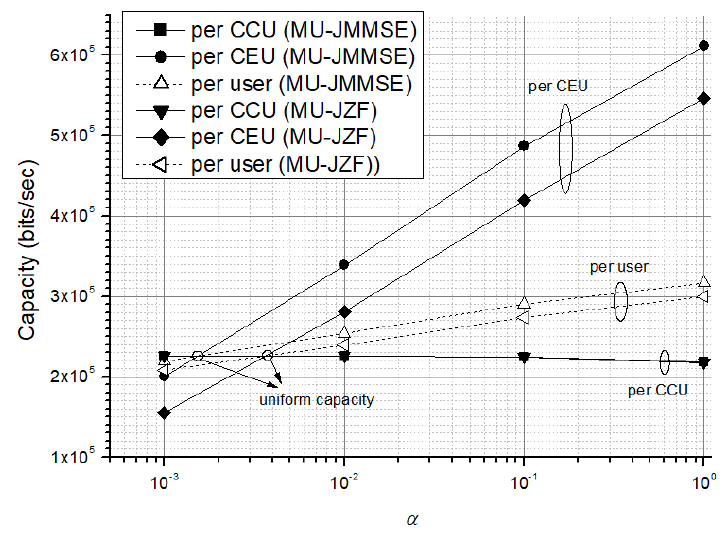
Figure 8. Capacity comparison for joint preprocessing schemes in MU-network MIMO as a function of α .